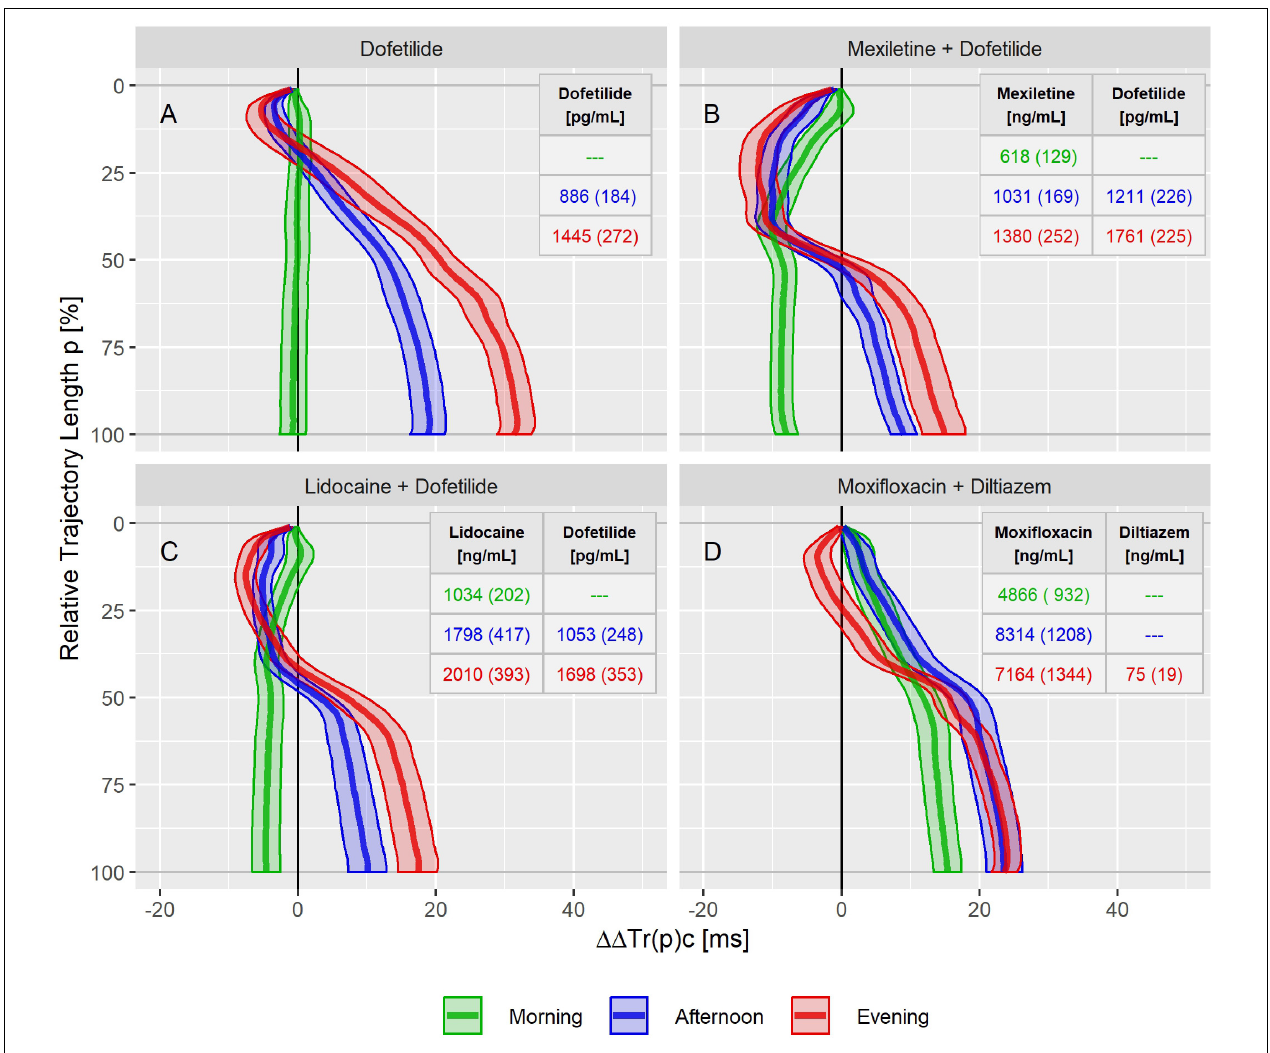
FIGURE 6 | Continuous drug effect profile estimates with 90% confidence bands for dofetilide (A) , mexiletine plus dofetilide (B) , lidocaine plus dofetilide (C) , and moxifloxacin plus diltiazem (D) at the three treatment timepoints in study B. Numbers denote the drug’s average (standard deviation) plasma concentration within the